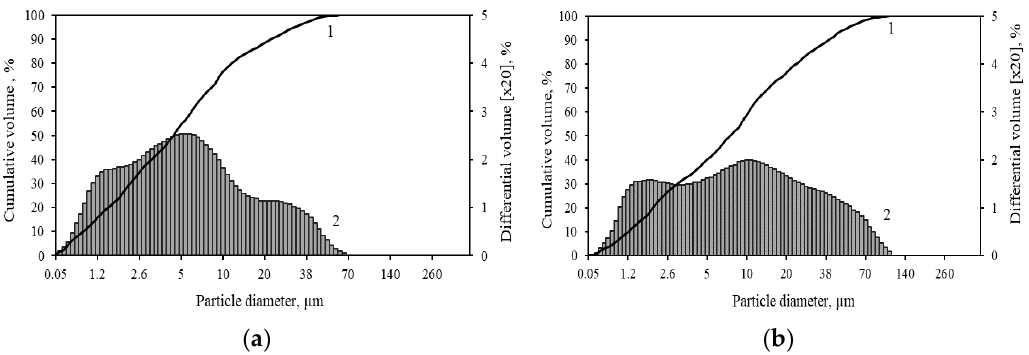
Figure 3. Particle size distribution of limestone ( a ) and clay ( b ), where 1—cumulative volume, 2— differential volume.